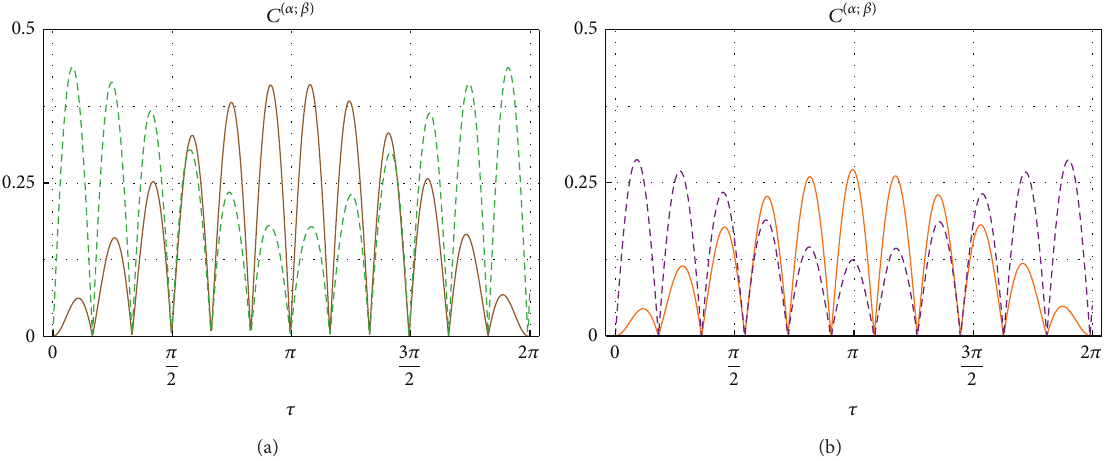
Figure 3: QFT instance (color online). In (a) the concurrences 𝐶 ( ] 𝑒 ; ] 𝑒 ) (full line) and 𝐶 ( ] 𝜇 ; ] 𝑒 ) (dashed line), in (b) the concurrences 𝐶 ( ] 𝑒 ; ] 𝜇 ) (full line) and 𝐶 ( ] 𝜇 ; ] 𝜇 ) (dashed line), as functions of the scaled time 𝜏 = (𝜔 2 − 𝜔 1 )𝑡 . The mixing angle 𝜃 and the parameters 𝑥 and 𝑝 are fixed as in Figure